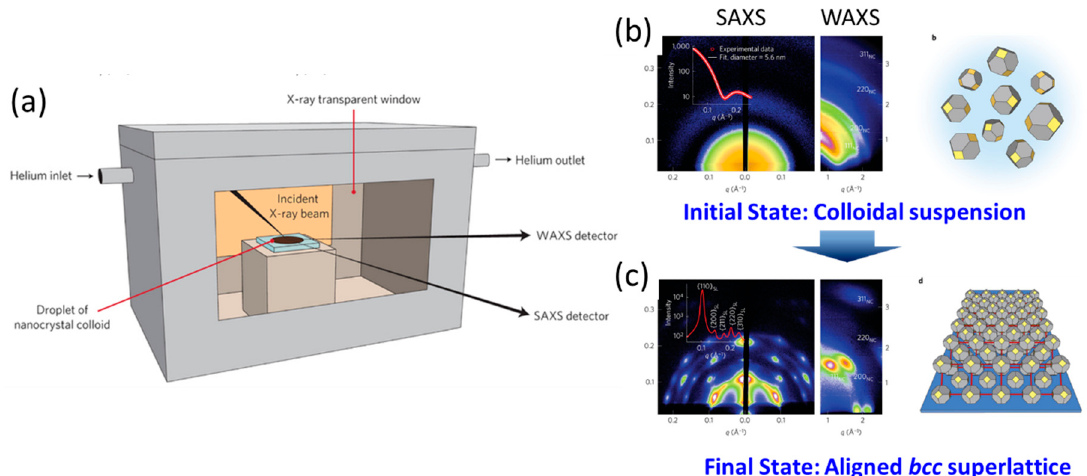
Figure 5. ( a ) Experimental set-up for simultaneous grazing incidence small-angle X-ray scattering (GISAXS) and grazing incidence wide-angle X-ray scattering (GIWAXS) measurements used for the in-situ investigation of the nanoparticle self-assembly process from dispersion by controlled solvent evaporation ( b ) and ( c ) are a short summary on experimental data (GISAXS and GIWAX patterns) and results of structural analyses showing the transformation of a disordered PbS nanoparticle dispersion to a highly ordered self-assembled bcc superlattice with crystallographically aligned nanocrystals (so-called mesocrystalline films). Figures are adapted from Ref. [76] with permission of the Macmillan Publishers Limited.